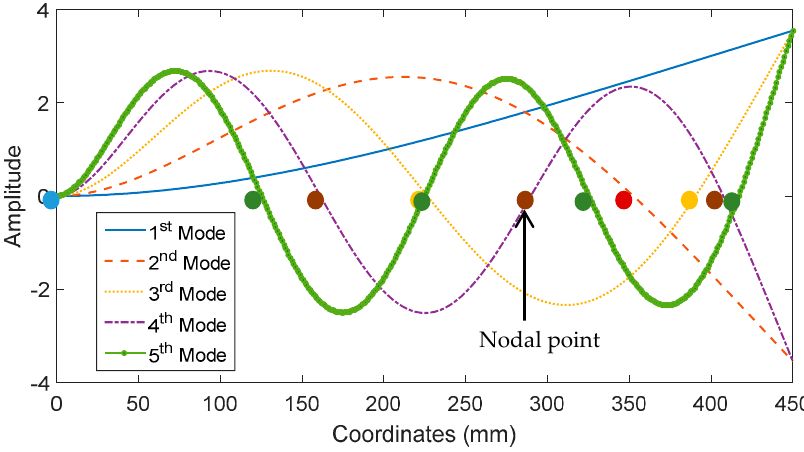
Figure 10. Mode shapes of the first five flexural vibration modes.